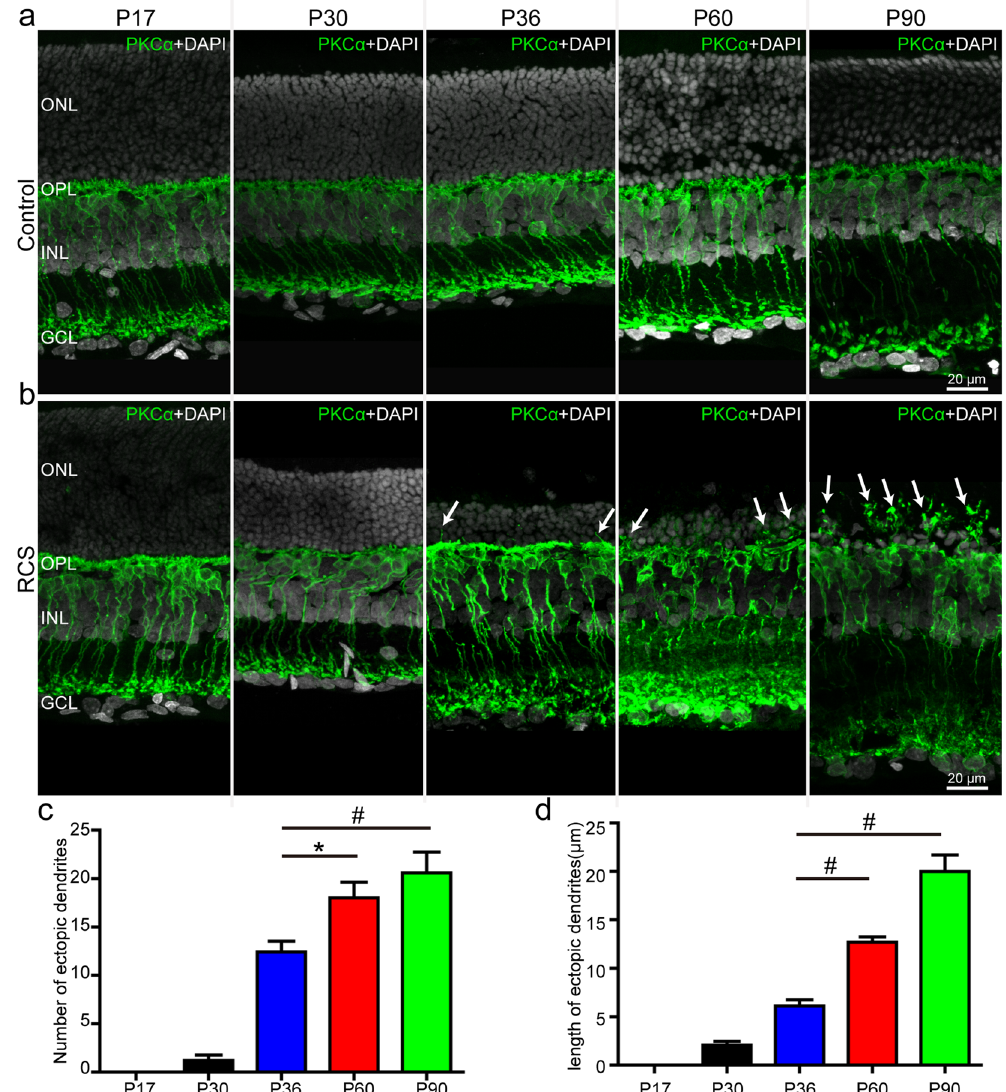
Figure 1. The morphological changes of RBCs during retinal degeneration in RCS rats. Immunostaining for PKC α in the retinae of ( a ) control rats, and ( b ) RCS rats at P17, P30, P36, P60 and P90. The nuclei were stained using DAPI. Arrows indicate RBC dendrites growing into the ONL. ( c ) Number of RBC ectopic dendrites per field view (213 µ m × 213 µ m) in RCS rat retinae at P17, P30, P36, P60 and P90 (n = 5). ( d ) Same for length of ectopic dendrites (n = 5). ONL, outer nuclear layer; OPL, outer plexiform layer; INL, inner nuclear layer; GCL, ganglion cell layer. Bars show means; error-bars, SEM. * p < 0.05; # p <